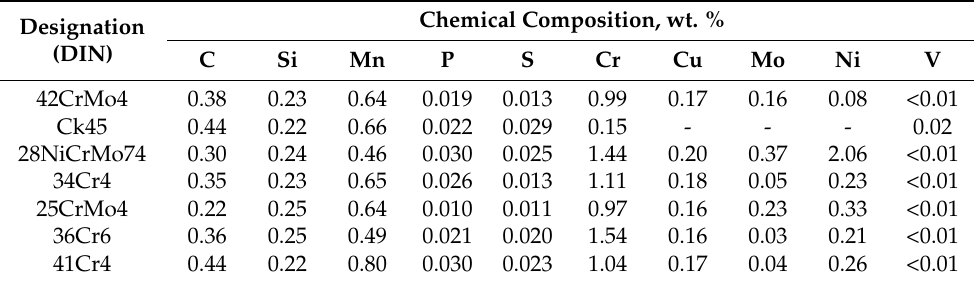
Table 1. Chemical composition of studied steels (balance